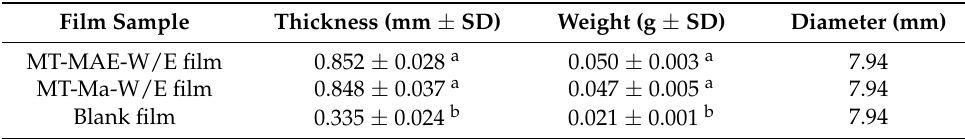
Table 3. Weight, thickness and diameter of film samples.